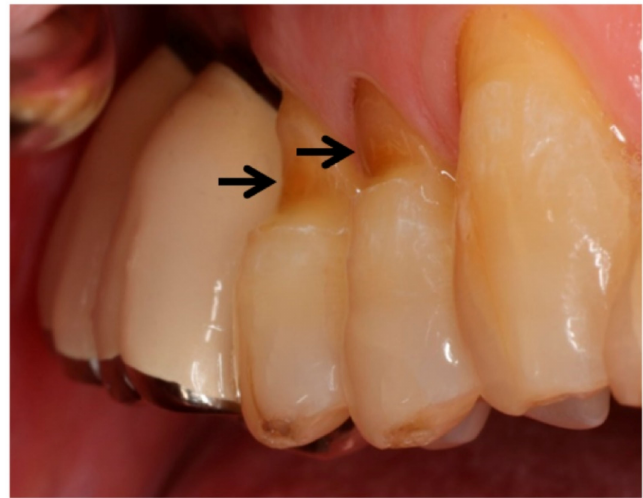
Figure 1. Clinical case of non-carious cervical lesions of teeth (indicated by arrows) caused by traumatic